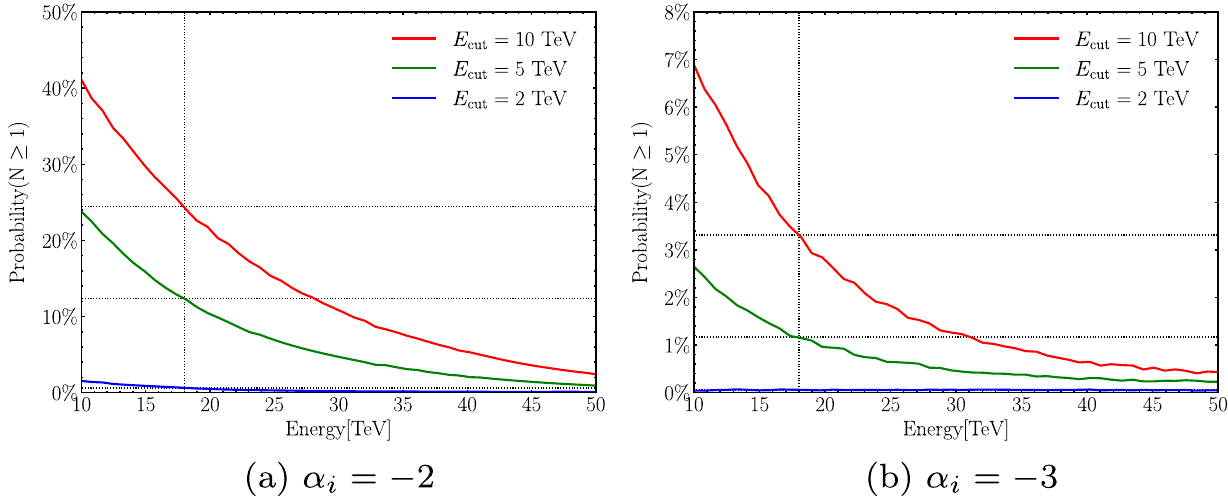
Fig. 2 Probability of predicting that LHAASO observes at least one photon of multi-TeV from GRB 221009A within 2000 s for E cut = 10 , 5 , 2 TeV respectively. The left panel shows the case of α i = − 2